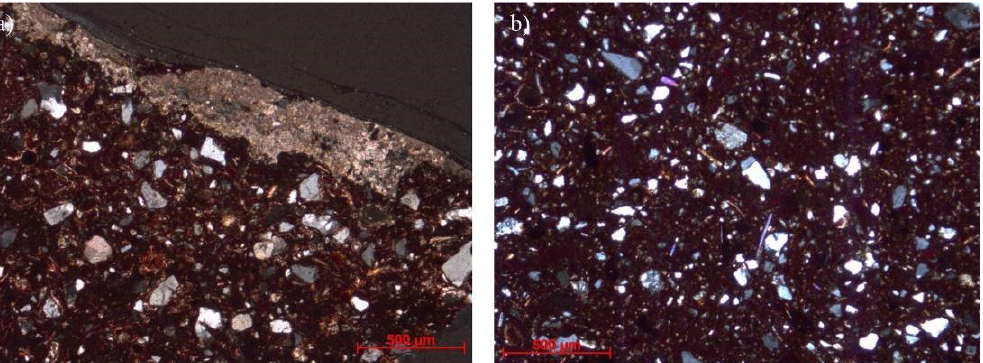
Figure 11. Microphotograph of thin sections of brick samples 1A and 1D, ( a ) and ( b ) respectively (through polarized optical microscopy; crossed nicols).